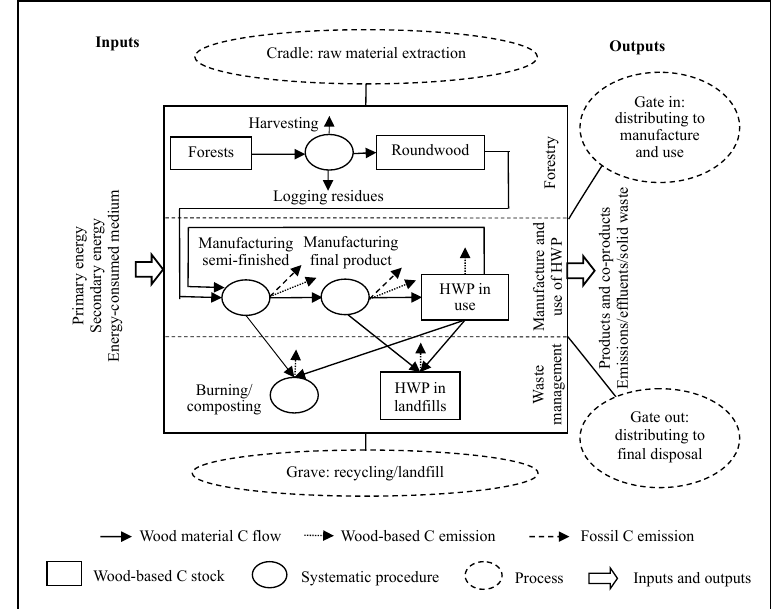
Figure 1. Wood-based carbon flow through the cradle-to-grave life cycle of harvested wood product (HWP).